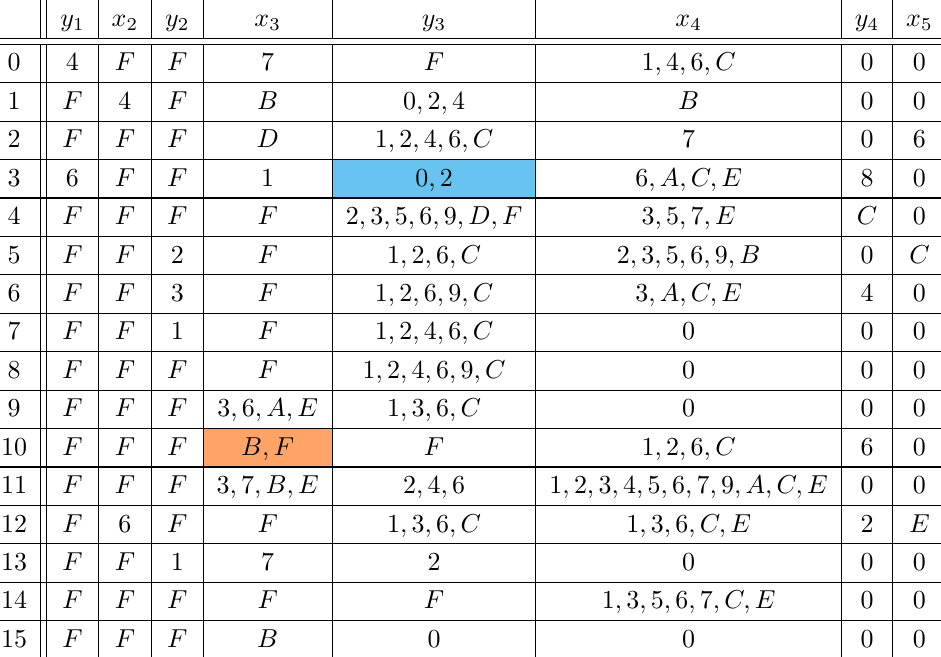
Table 4: Internal state at Step s + 1 - second